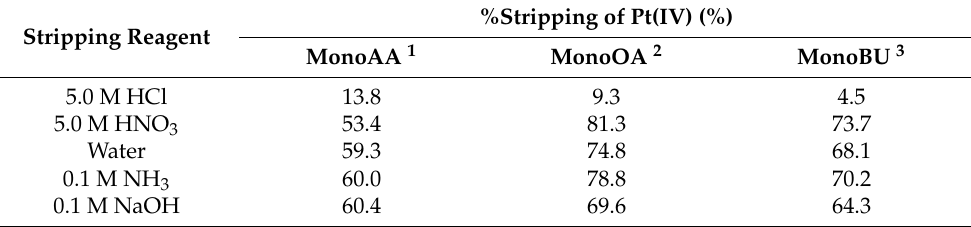
Stripping percentage of Pt(IV) from Pt(IV) loaded organic phase by MonoAA, MonoOA, and MonoBU. [Extractant] org,i = 1.0 M in n -dodecane/2-ethylhexanol (80 vol%/20